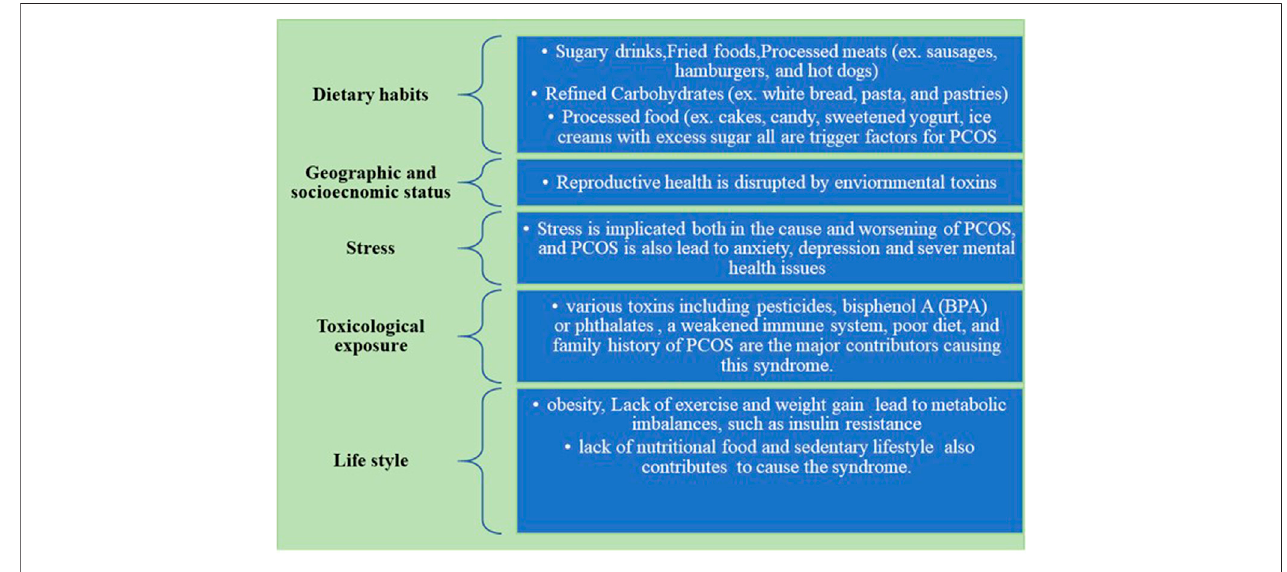
FIGURE 1 | Environmental factors affecting PCOS.